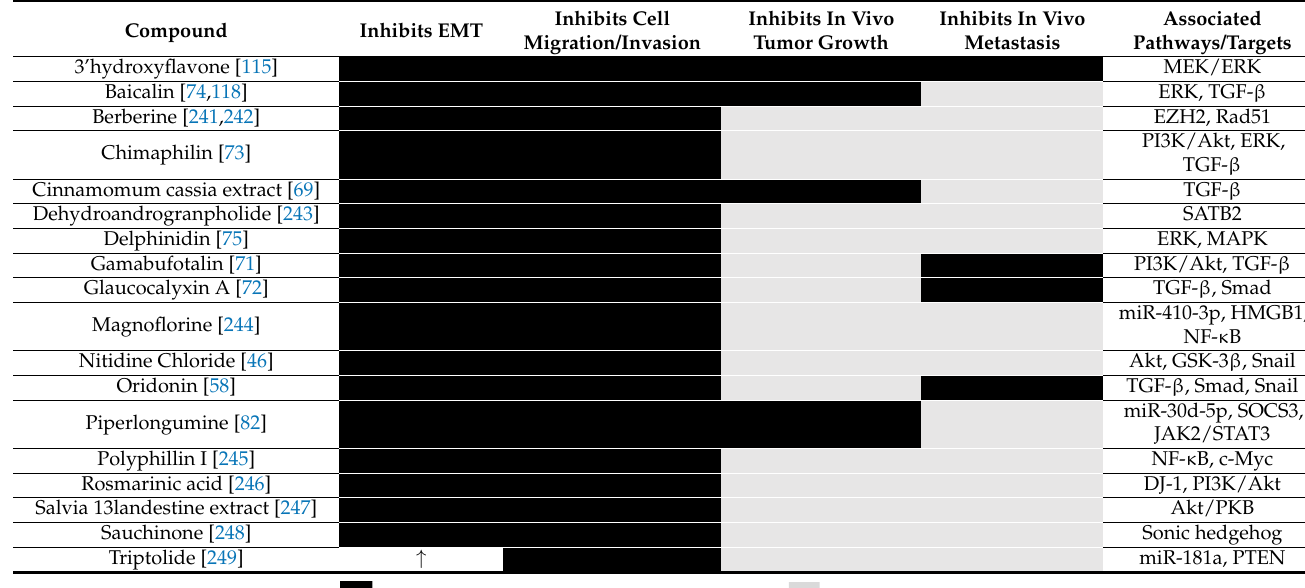
Table 6. Traditional and herbal medicine effects on EMT in OS.